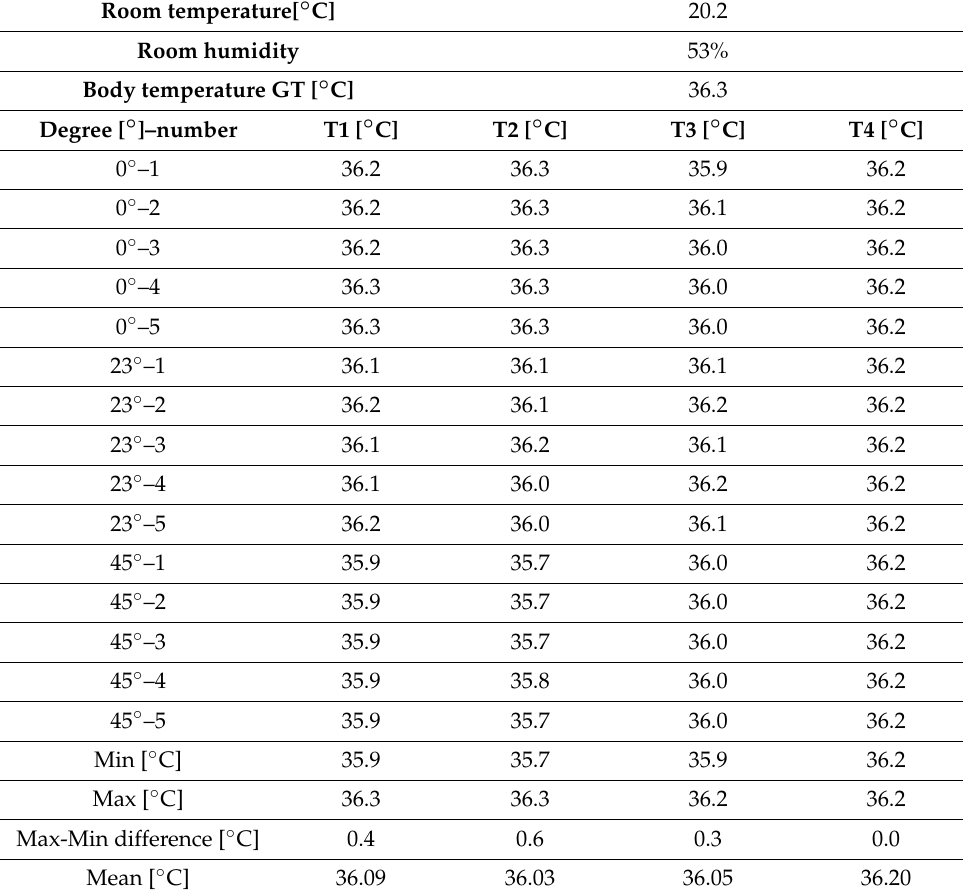
Table A7. Body–device angle experiment. Subject 1 body temperature